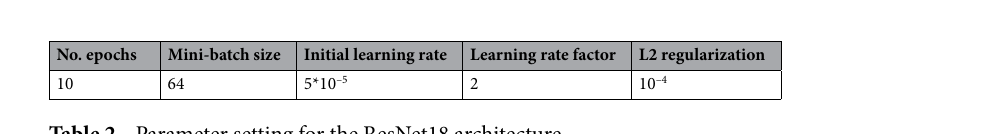
Table 2. Parameter setting for the ResNet18